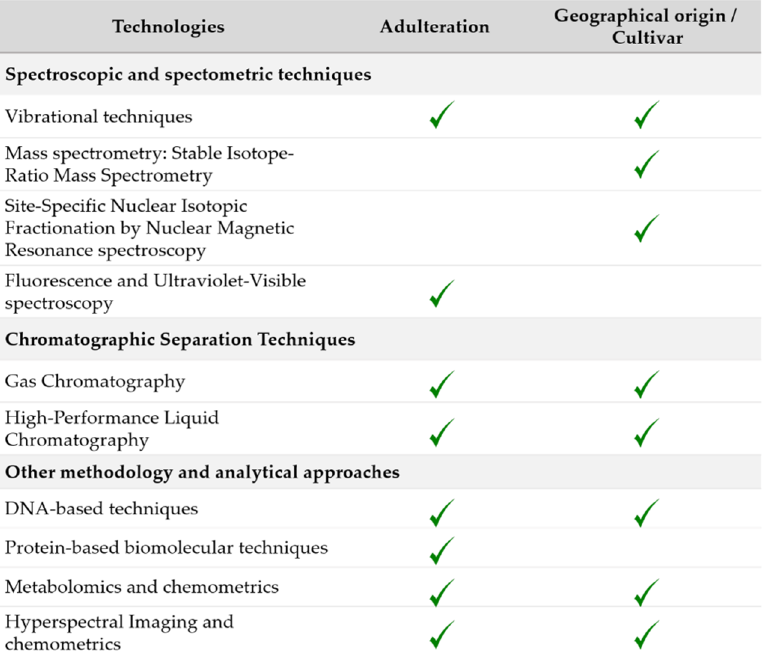
Figure 2. Applications of the selected techniques for olive oil authentication.